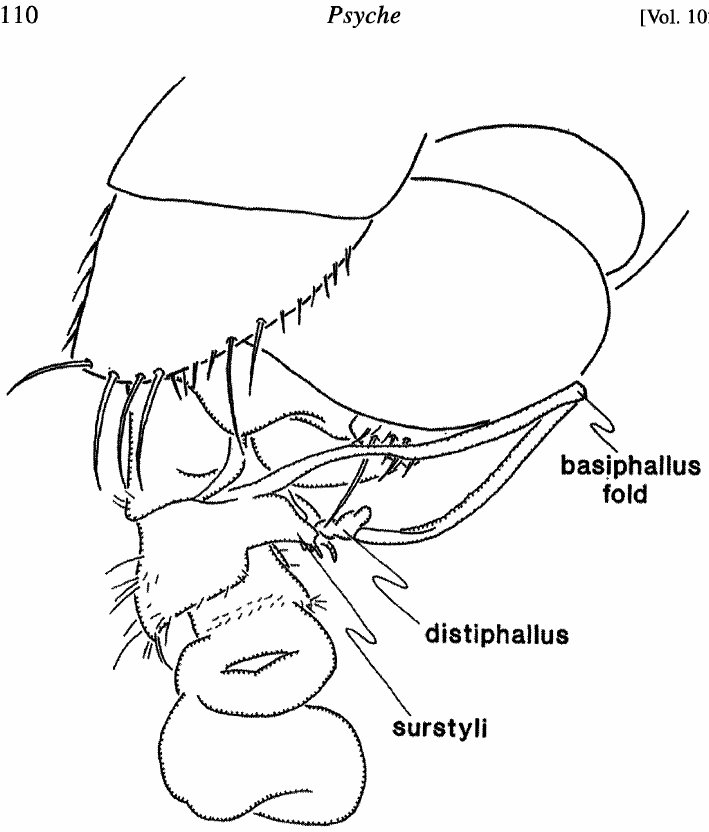
Fig. 8. Posterior portion of the abdomen of a male which was frozen 30 sec after he established genital contact with a female. The male fell free of the female, indi- cating that he had not introduced his aedeagus in the female’s vagina or had achieved only very shallow intromission. His basiphallus was sharply bent, and the distiphallus (not folded back on the basiphallus--compare with Fig. 10) was posi- tioned between the surstyli, near the site of the genital opening of the female when her aculeus was held by the